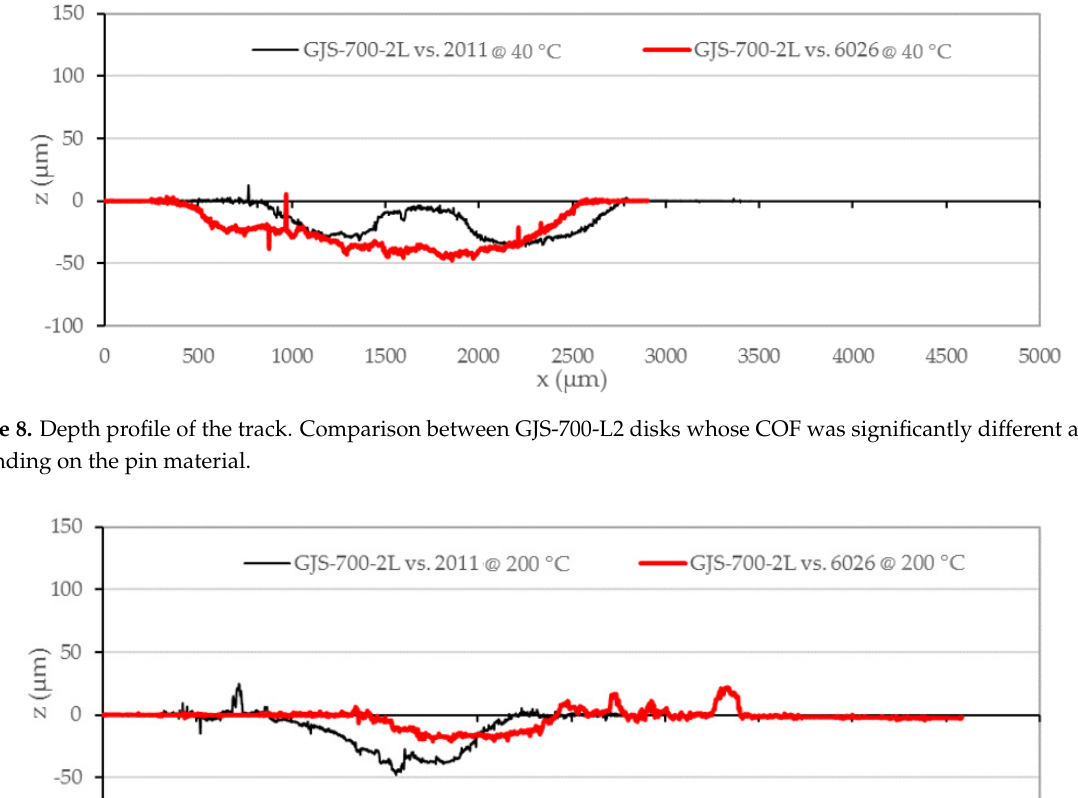
Figure 7. Depth profile of the track. Tool steel vs. cast iron wear profile comparison at 40 ◦ C.